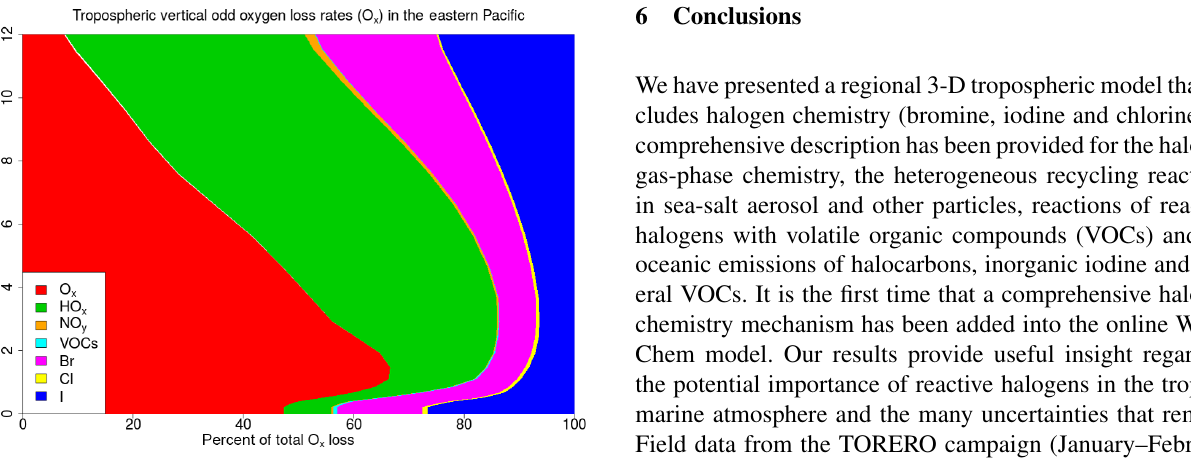
Figure 14. Regional average percentage contribution of each ozone- depleting family to the total tropospheric vertical odd oxygen loss (O x ) for the WRF-DEBROM